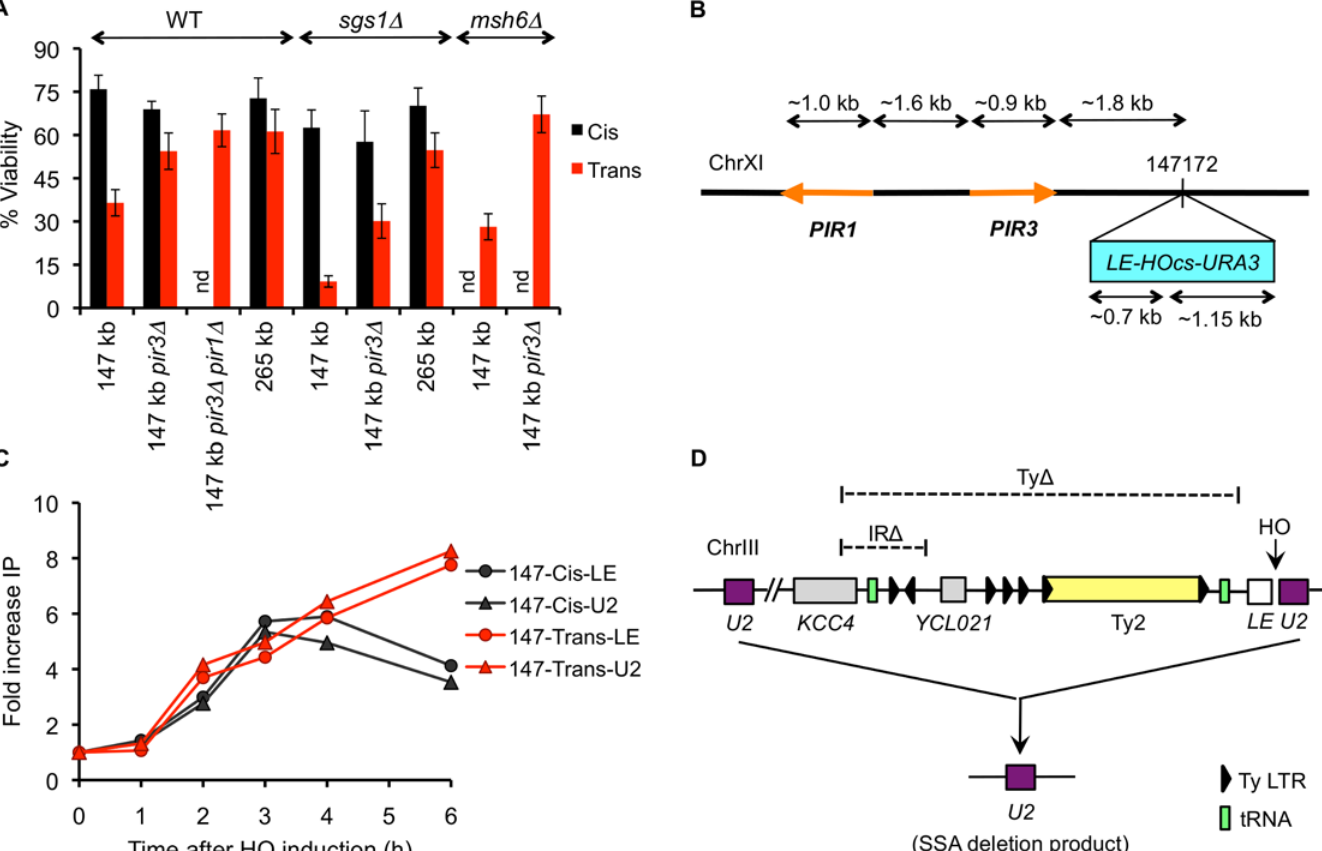
Fig 5. Adjacent PIR sequences interfere with GC repair in Trans. (A) Viabilities of the indicated WT, sgs1 Δ and msh6 Δ 147- and 265- Cis and Trans strains (nd indicates not done). Data represent mean ± S.D. (n (cid:1) 5). (B) Schematic representation of Chr XI features surrounding the site of insertion of the LE-HOcs-URA3 cassette in the 147-Trans strain. The LE-HOcs-URA3 cassette was inserted at position 147142 on the left arm of Chr XI. Orange lines represent the PIR genes and the arrowheads indicate their relative orientations. The distance of PIR3 gene from PIR1 and LE-HOcs-URA3 cassette is indicated. The corresponding Cis strain contains a NAT -marked 5 ’ truncated ura3-HOcs-URA3 cassette at position 147172. (C) Rad51 ChIP signal at the LEU2 donor on Chr III representing the kinetics of strand-invasion by LE and U2 ends in 147- Cis and Trans strains. Primers 300 bp and 200 bp upstream of the LEU2 donor and 150 bp and 25 bp downstream of the LEU2 donor were used to study the kinetics of strand-invasion by the LE and U2 ends, respectively. (D) Schematic representation of the YMV80 SSA strain harboring an HOcs within the leu2 gene at its endogenous locus, and a homologous U2 sequence at the his4 locus ~25 kb distal to the LE-HOcs-U2 . Dotted lines indicate the regions spanning the Ty2 retrotransposon element, Ty1 LTRs (long terminal repeats) and tRNA genes that have been deleted in the Ty Δ and IR Δ strains, respectively. Ty Δ results in a net deletion of 4.7 kb. Figure not drawn to scale.